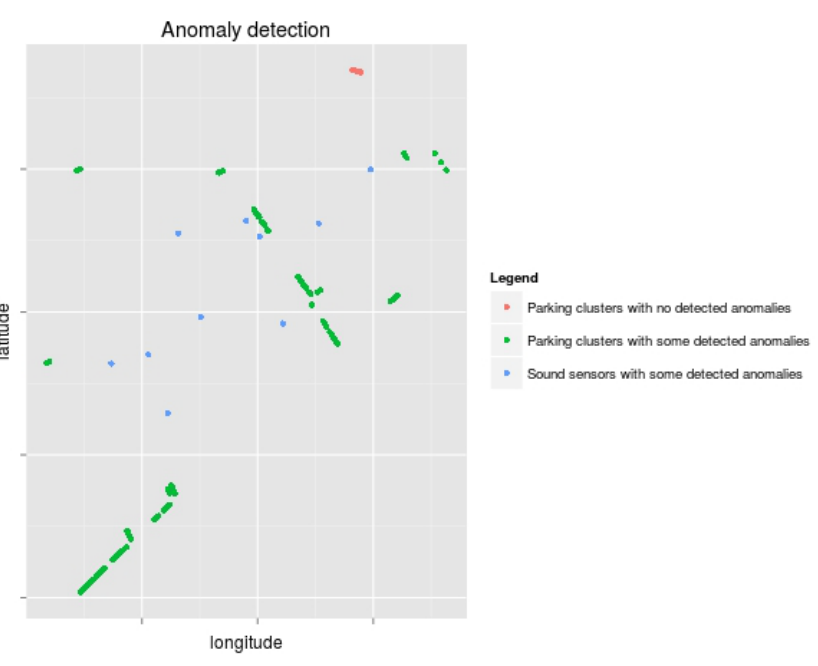
Figure 9. Sound sensors and parking sensor clusters where the attack has been